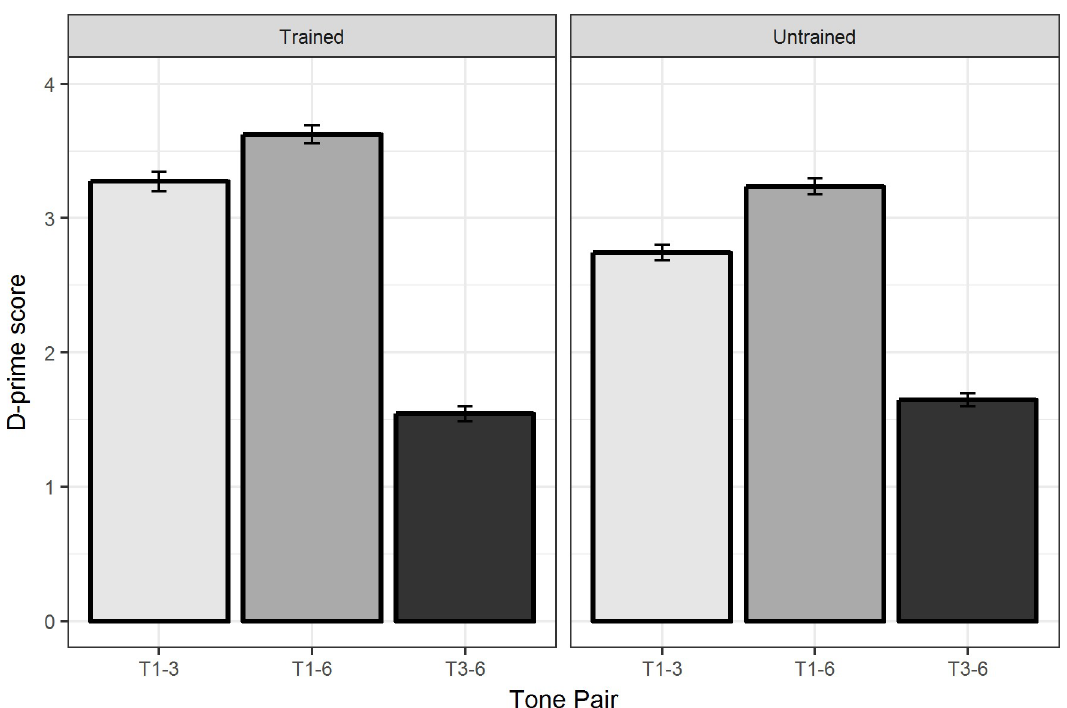
Fig 5. The participants’ mean d -prime scores of T1-T3, T1-T6, and T3-T6 trials produced by the trained talker (left panel) and the untrained talker (right panel). The error bars represent one standard error of the mean.